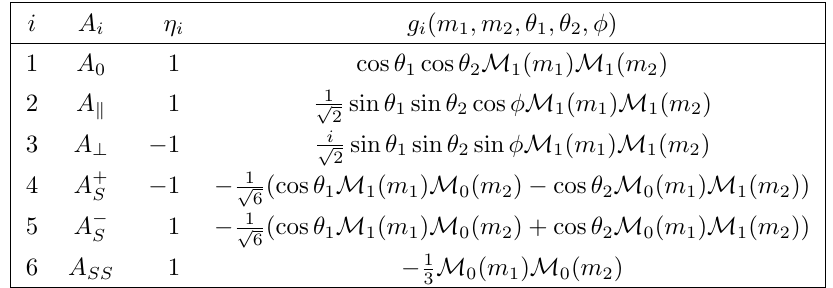
Table 2 . Amplitudes, A i , and angle-mass functions, g i ( m 1 ; m 2 ; (cid:18) 1 ; (cid:18) 2 ; (cid:30) ), of the di(cid:11)erential de- cay rate of eq. (2.5). In particular, A 0 , A and A ? are the longitudinal, parallel and transverse k helicity amplitudes of the P-wave whereas A + and A (cid:0) are the combinations of CP eigenstate am- S S plitudes of the SV and V S states and A SS is the double S-wave amplitude. The table indicates the corresponding CP eigenvalue, (cid:17) i . The mass propagators, ( m ), are discussed in the text. M 0 ; 1 where A , A and A are the longitudinal, parallel and transverse amplitudes of the P-wave. 0 ? k Therefore, f is the fraction of B 0 K (cid:3) 0 K (cid:3) 0 longitudinally polarised decays. The polar- L ( s ) ! isation fractions are preferred to the amplitude moduli since they are independent of